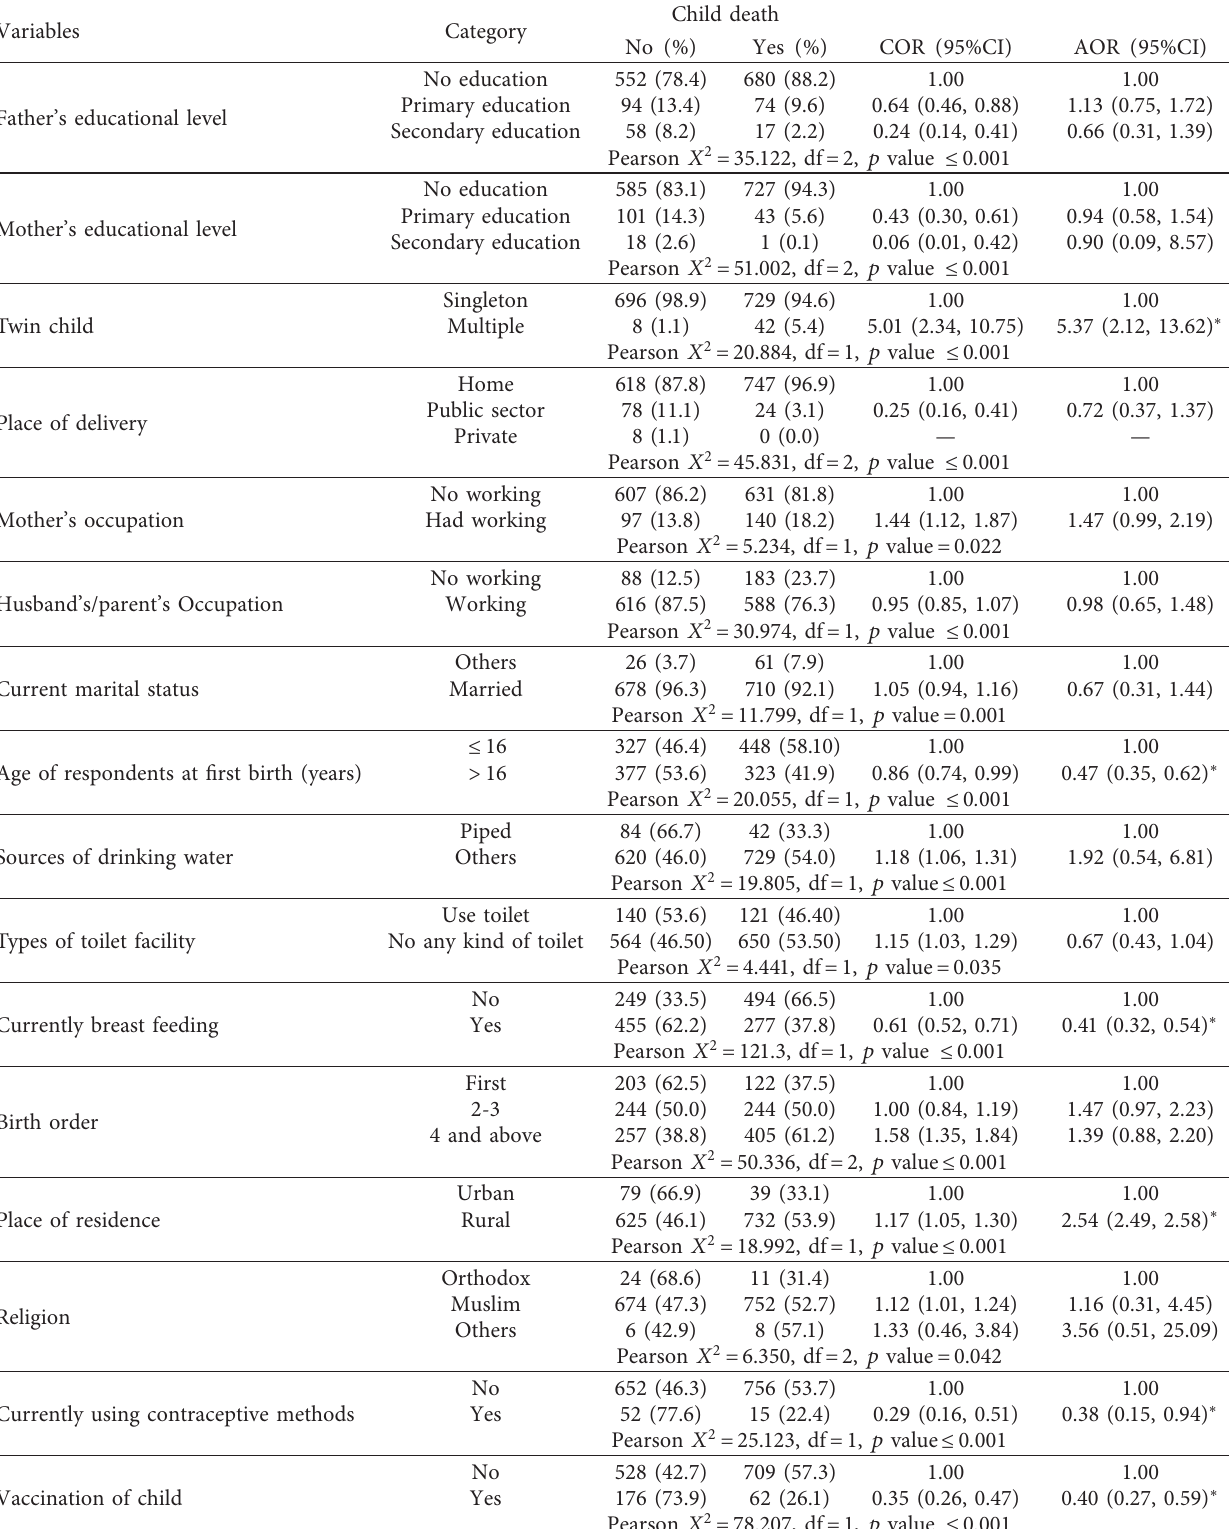
Table 2: Factors associated with child mortality among children of 0–59 months in Afar region, Ethiopia ( n �